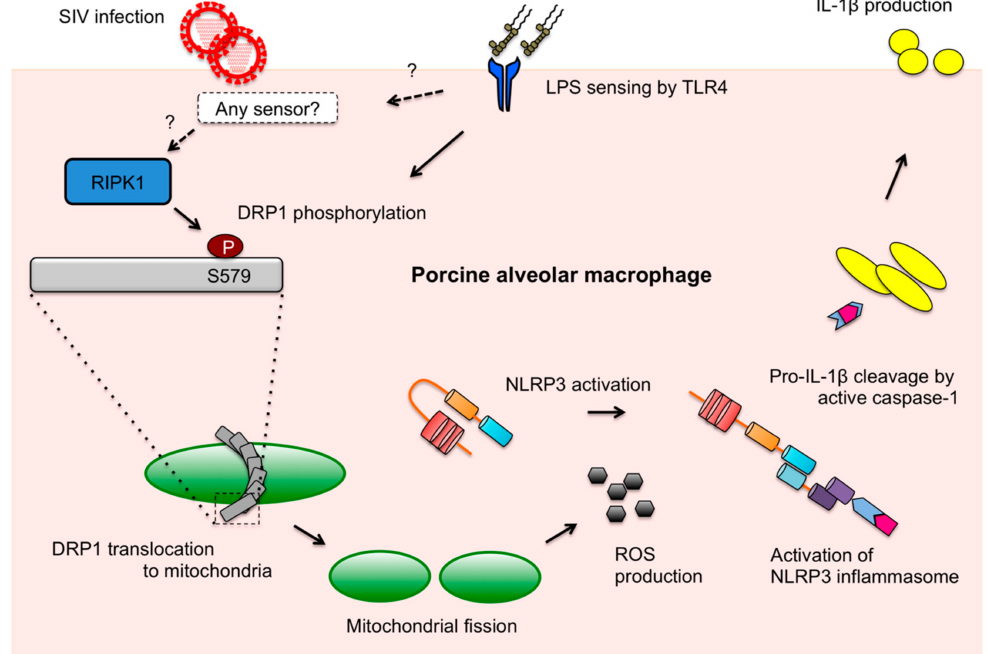
Figure 6. A proposed model of RIPK1/DRP1-mediated IL-1 β production in SIV-infected PAMs. Recognition of IAV RNA by endosomal TLRs or RIG-I is known to induce pro-IL-1 β synthesis. SIV infection turns on the RIPK1/DRP1 signaling for the NLRP3 inflammasome activation in PAMs. SIV seems to utilize the RIPK1 function, while how RIPK1 is activated by SIV or whether an upstream sensor plays a role in its activation is unclear. By interacting with DRP1 and through its kinase activity, RIPK1 induces the phosphorylation of porcine DRP1 at S579. Upon DRP1 translocation to mitochondria, mitochondrial fission occurs and ROS is generated. This promotes the activation of NLRP3 that is required for the NLRP3 inflammasome assembly and caspase-1 activation. Active caspase-1 converts pro-IL-1 β into mature IL-1 β , which is critical for SIV-induced lung inflammation. Sensing LPS by TLR4 is known to induce the pro-IL-1 β expression, and this also induces the DRP1 phosphorylation leading to the NLRP3 inflammasome activation in PAMs, although it is unclear whether LPS activates any upstream regulator of